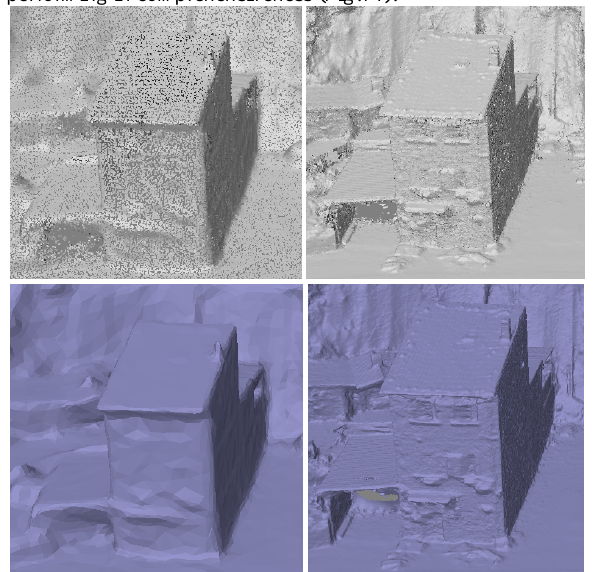
Figure 14. Data fusion model. Top: (left) low and (right) high parameters point cloud. (down) 3D